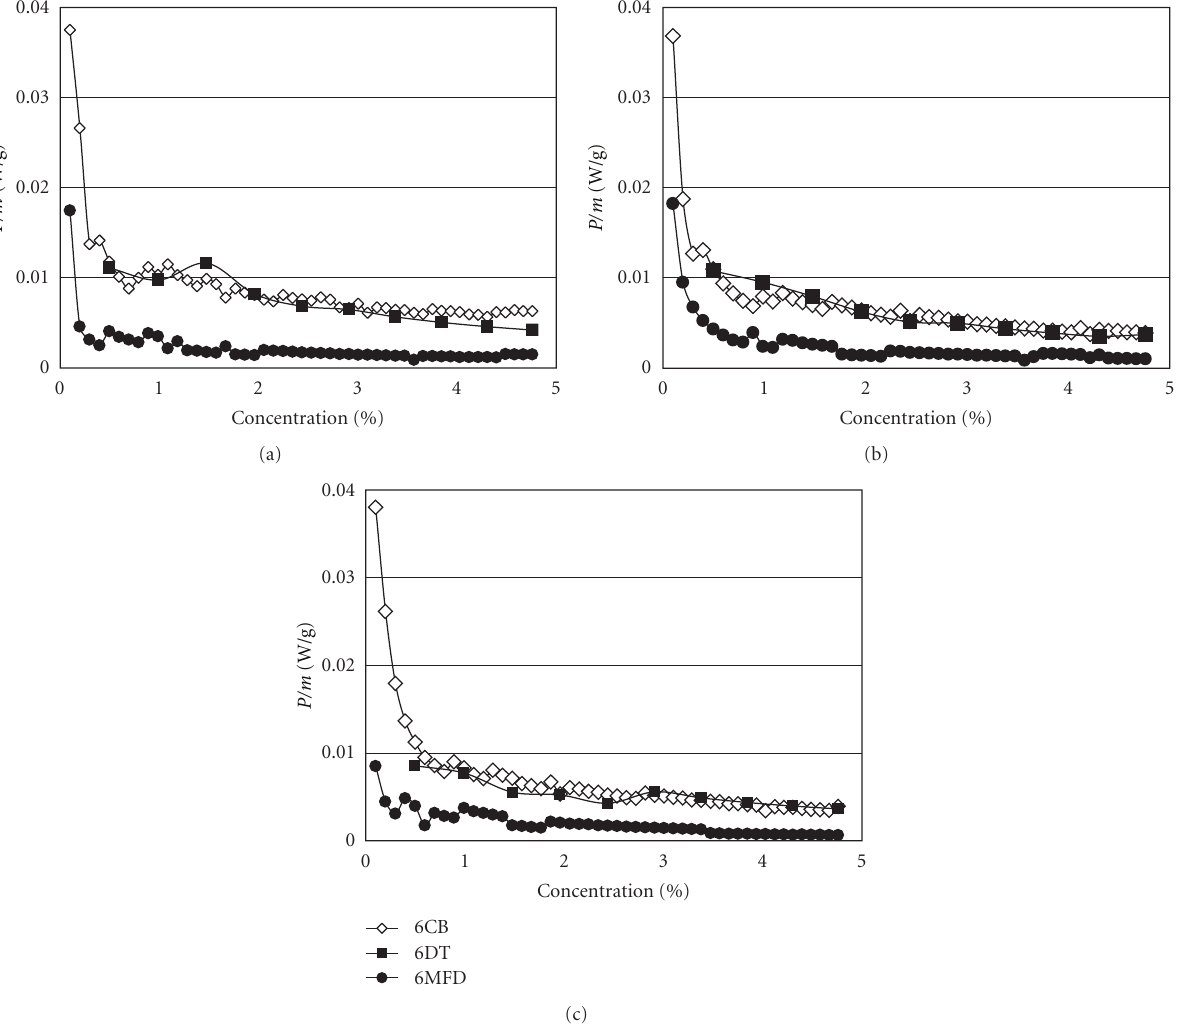
Figure 7: Power per unit solid mass (W/g) versus concentration (%), at varying impeller geometries. (a) size of activated carbon 1.40– 2.36mm, (b) size of activated carbon 1.00–1.40 mm, and (c) size of activated carbon 0.75–1.00